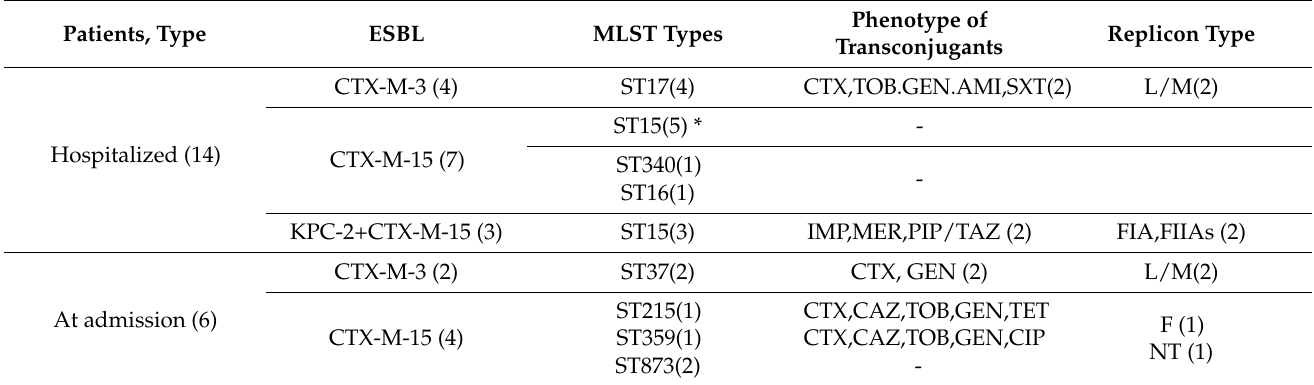
Table 2. ESBL/carbapenemases, Multilocus Sequence Typing (MLST), replicon typing, and transconjugant characteristics of 20 K. pneumoniae